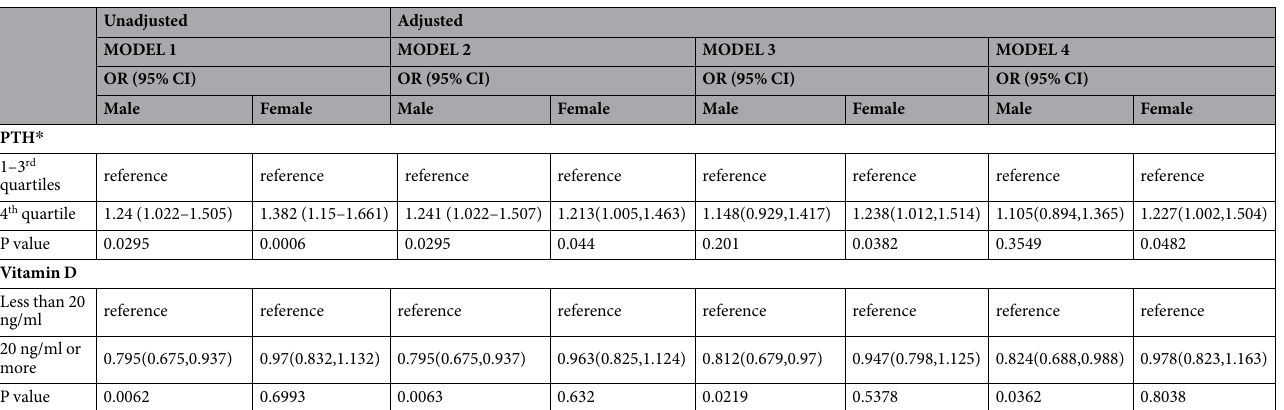
Table 4. Multiple logistic regression analysis (Presence of Metabolic syndrome – PTH or Vitamin D). Statistics were carried out using Logistic regression. adjusted for age, sex, self-pay of cancer screening, weight variation, waist-height ratio, physical activity, drink, smoking. MODEL 1 non-adjusted. MODEL 2 age, sex. MODEL 3 age, sex, smoke, exercise, education levels, income status, calcium intake. MODEL 4 age, sex, smoke, exercise, education levels, income status, calcium intake, PTH (or vitamin D). * The cut-off values for the 4 th quartiles of PTH was 76.8 pg/ml in male and 77.6 pg/ml in